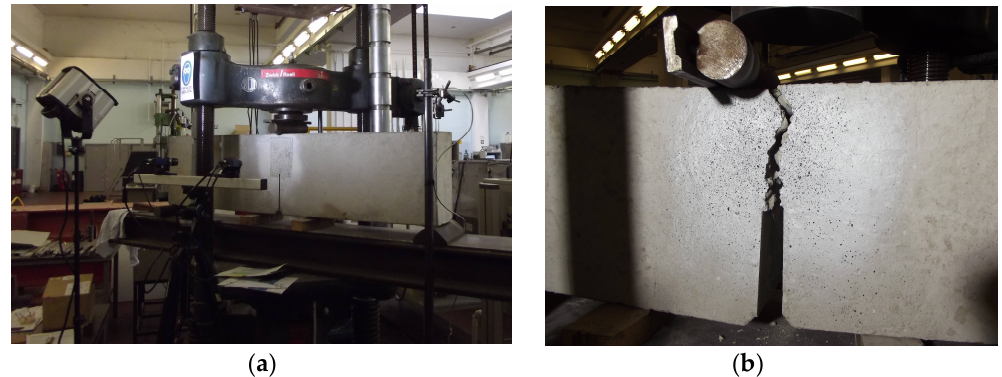
Figure 2. ( a ) Experimental set-up for DIC measurements; ( b ) mid-span region after collapse.